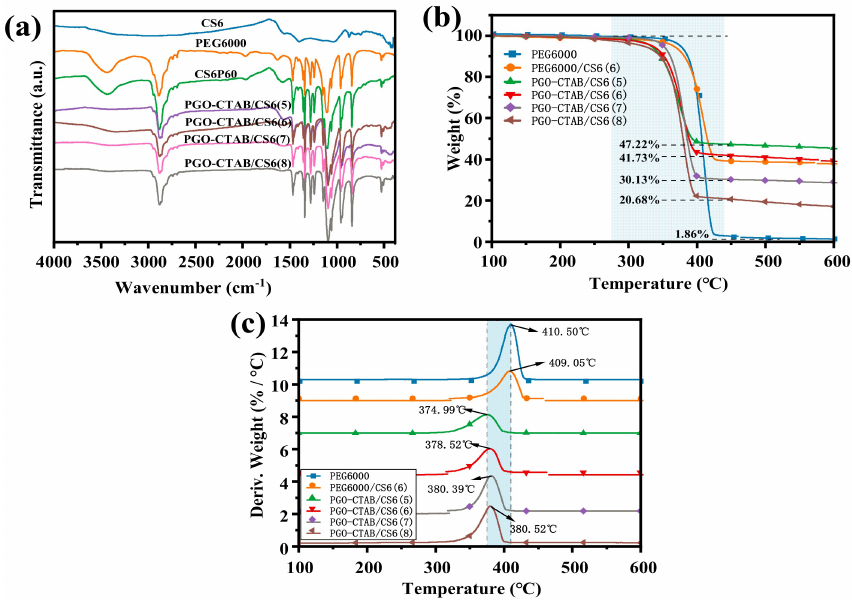
Figure 6. ( a ) FTIR curves, ( b ) TGA, and ( c ) DTG curves of PEG6000, PEG6000/CS6(6) and PGO- Polymers 2023 , 15 , x FOR PEER REVIEW CTAB/CS6(5 \ 6 \ 7 \ 8) PCMs.